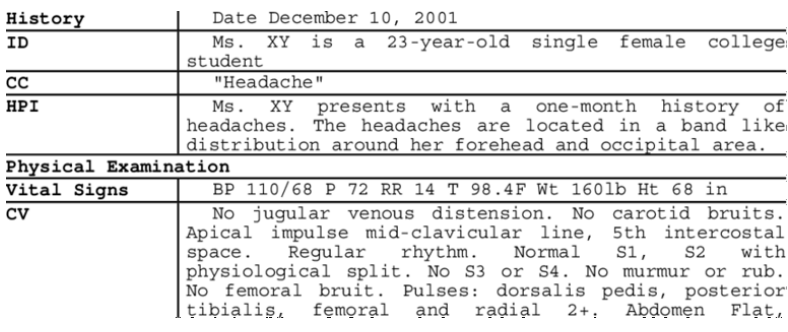
Figure 1. Example of medical record with plain text in it